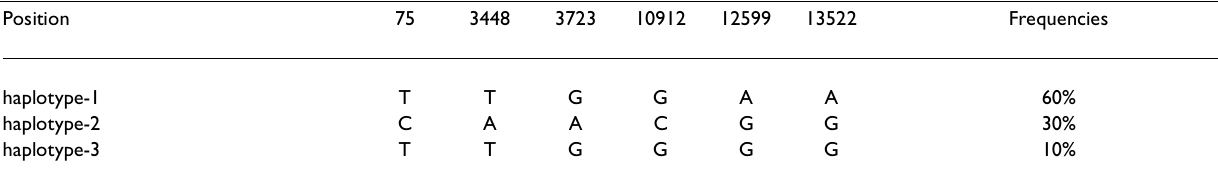
Table 3: Haplotype frequencies of six SNPs of the IHRP gene